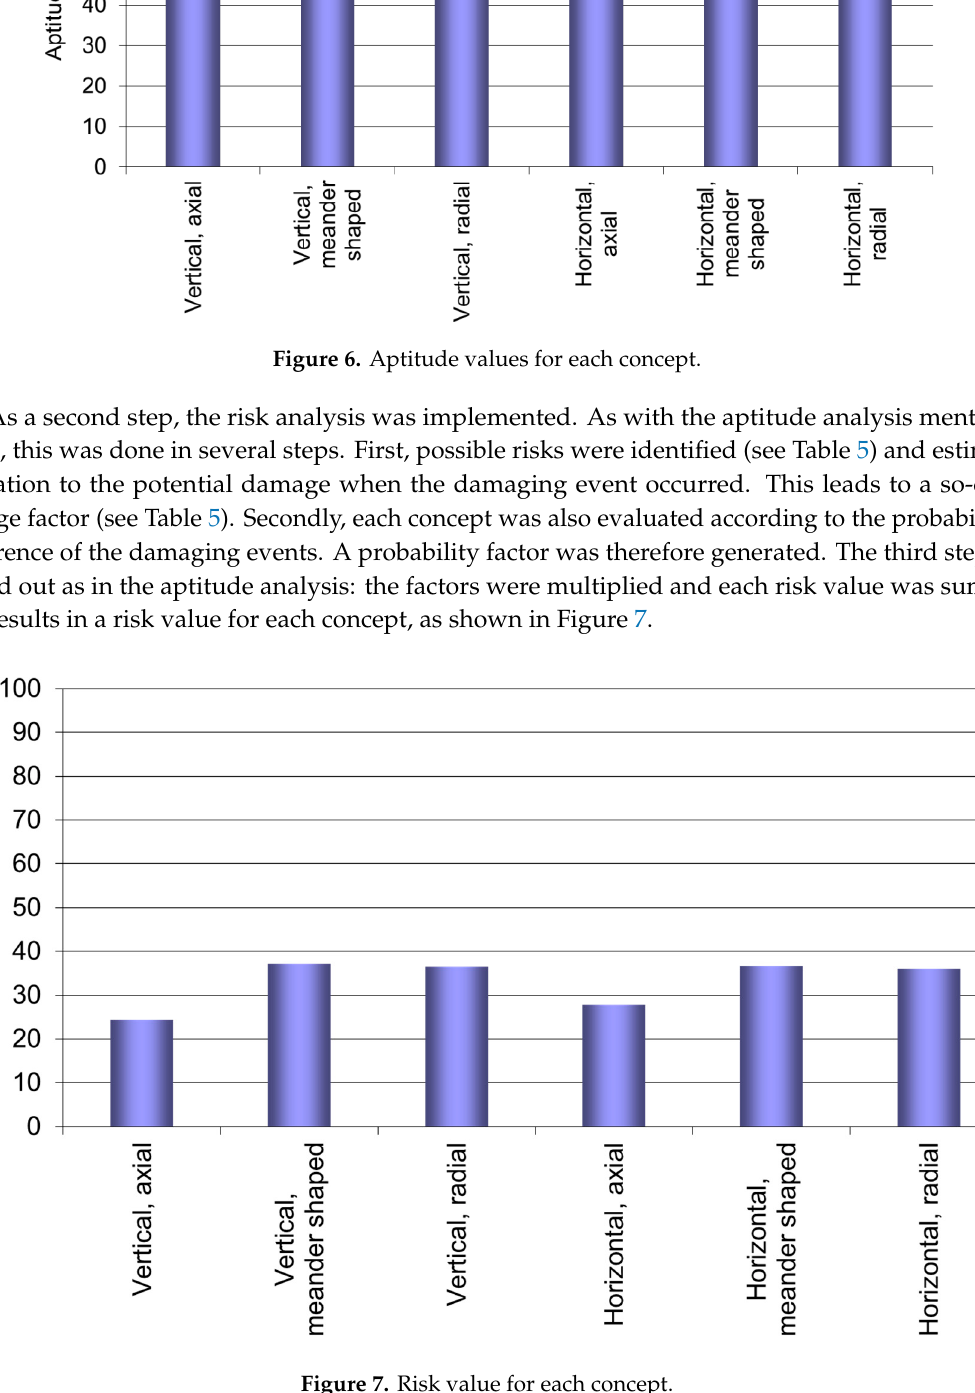
Figure 7. Risk value for each concept.